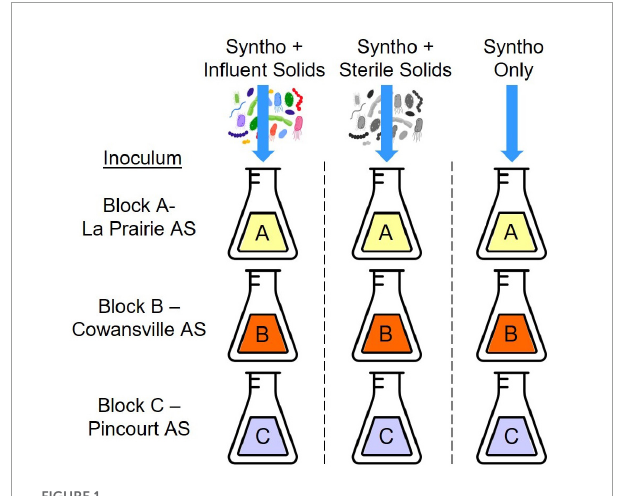
FIGURE1 One set of reactors which received one source of influent solids (27 reactors). Reactors were inoculated with three different activated sludge communities (Block A-C). One third of the reactors received synthetic wastewater (Syntho) supplemented with influent solid which was the group with immigration (9 reactors). Another third of the reactors received Syntho and sterile solids which acted as a substrate control (9 reactors). The final third of reactors received Syntho only and acted as a continuity control (9